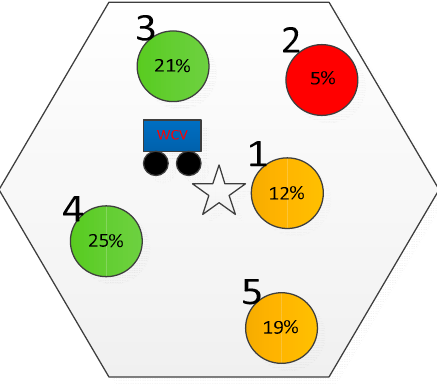
Figure 5. An example to introduce the node replacement strategy.